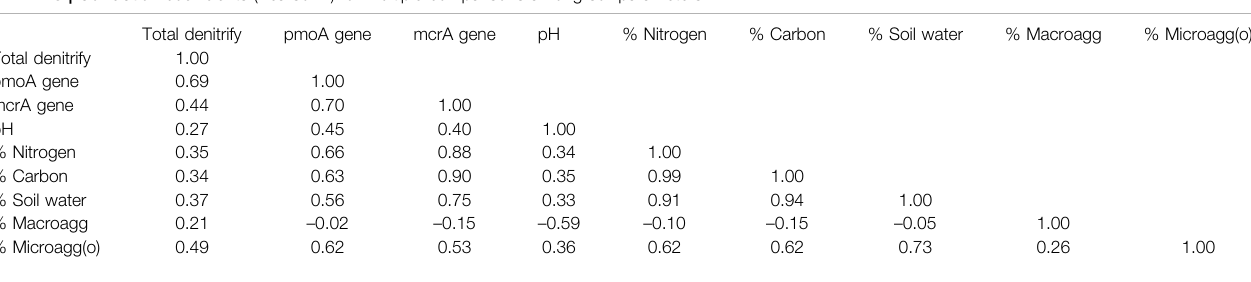
TABLE 8 | Correlation coef fi cients (Pearson r) for multiple comparisons among soil parameters. Total